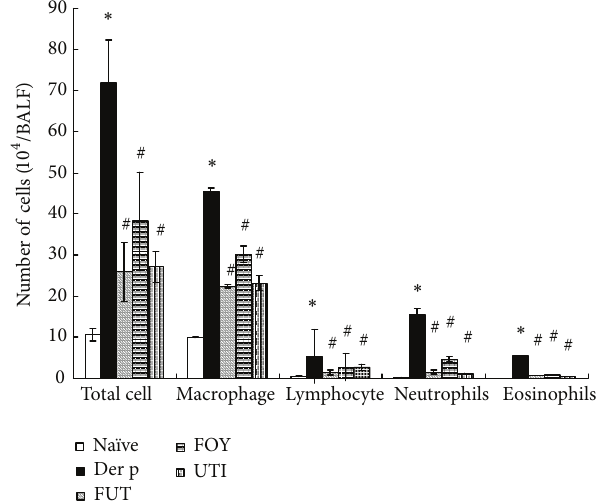
Figure 2: Effects of protease inhibitors on Der p-induced airway inflammatory cell infiltrates in BALF. Total cell numbers and cell differentials in BALF of BALB/c mice were determined at 72 h after the last Der p challenge, as described in Methods. Results are expressed as means ± SDs for 6 mice/group. ∗ 𝑃 < 0.05 versus na¨ıve group; # 𝑃 < 0.05 between Der p-treated